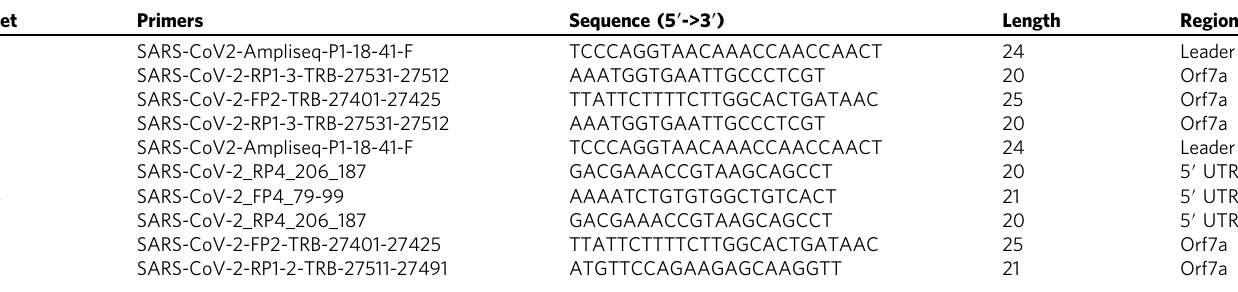
Table 6 Table showing the primers designed and used to detect speci fi c targets in the SARS-CoV-2 genome.